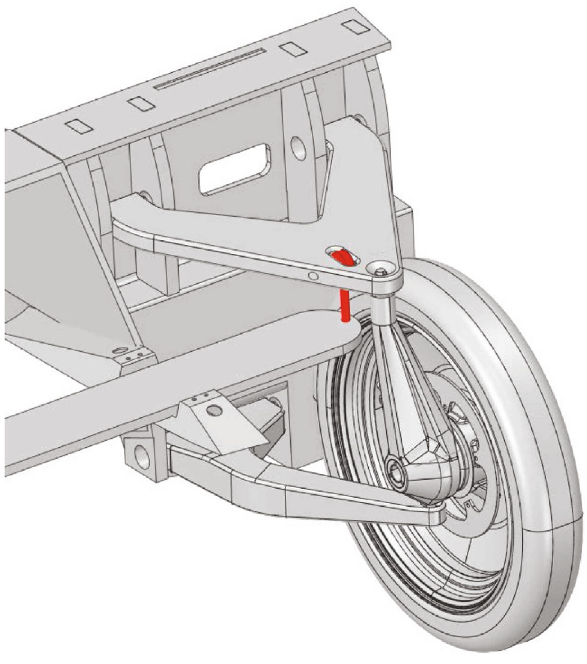
Figure 2: Design of the front suspension with the rod depicted in